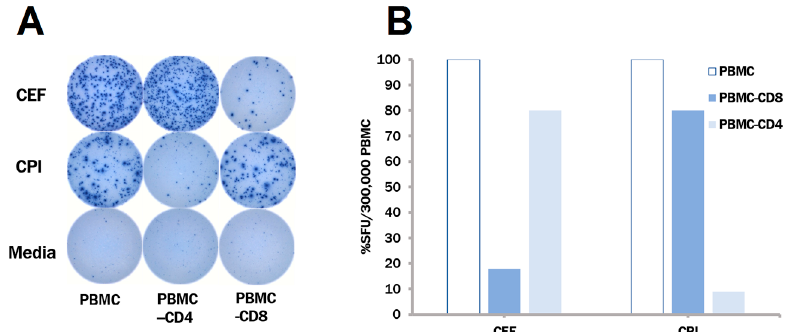
Figure 3. CPI (inactivated cytomegalo-, parainfluenza-, and influenza virions) recalls CD4 cells, CEF, (peptides of Cytomegalo-, Epstein-Barr and Flu-virus) recalls CD8 cells, respectively. Unseparated, as well as CD4- and CD8 cell-depleted PBMC of the same donor were tested for the CEF and CPI recall response, as specified. Representative well images are shown in ( A ). In ( B ) the percentage of response in the depleted PBMC fractions is shown relative to the unseparated PBMC.